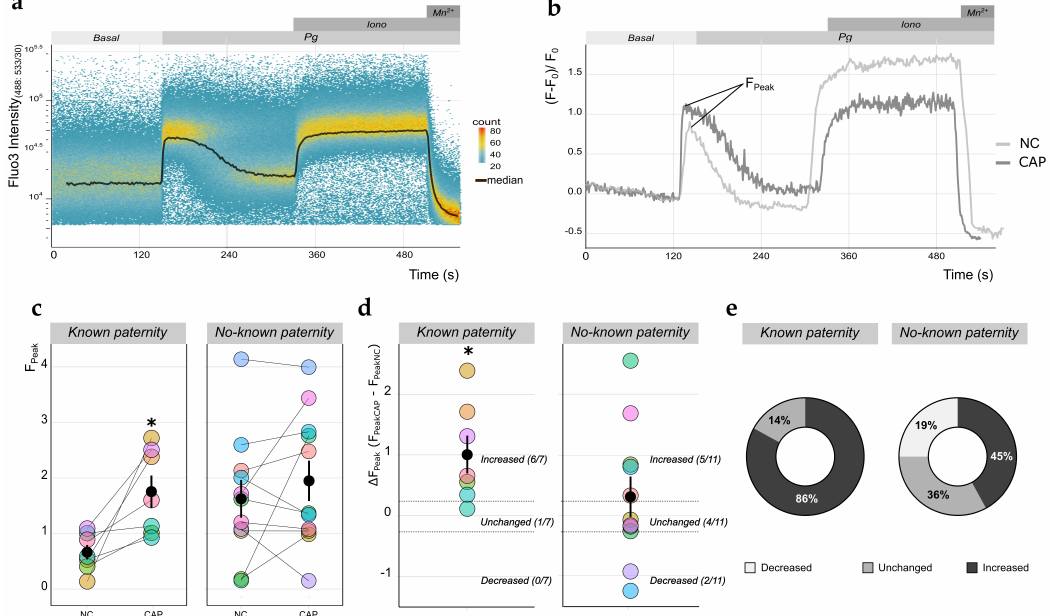
Figure 4. Qualitative evaluation of progesterone (Pg)-induced intracellular calcium concentration [Ca 2+ ] i changes in human sperm. ( a ) Representative time-lapse flow cytometry (TLFC) Fluo3-AM (Fluo3) fluorescence density plot of a sperm sample from a known paternity donor under capacitation conditions. Gray boxes above the plot indicate the nature and duration of the employed stimuli: progesterone (Pg), ionomycin (Iono), and manganese chloride (Mn 2+ ). The dark solid line indicates the median fluorescence value. ( b ) Representative example of normalized median fluorescence values